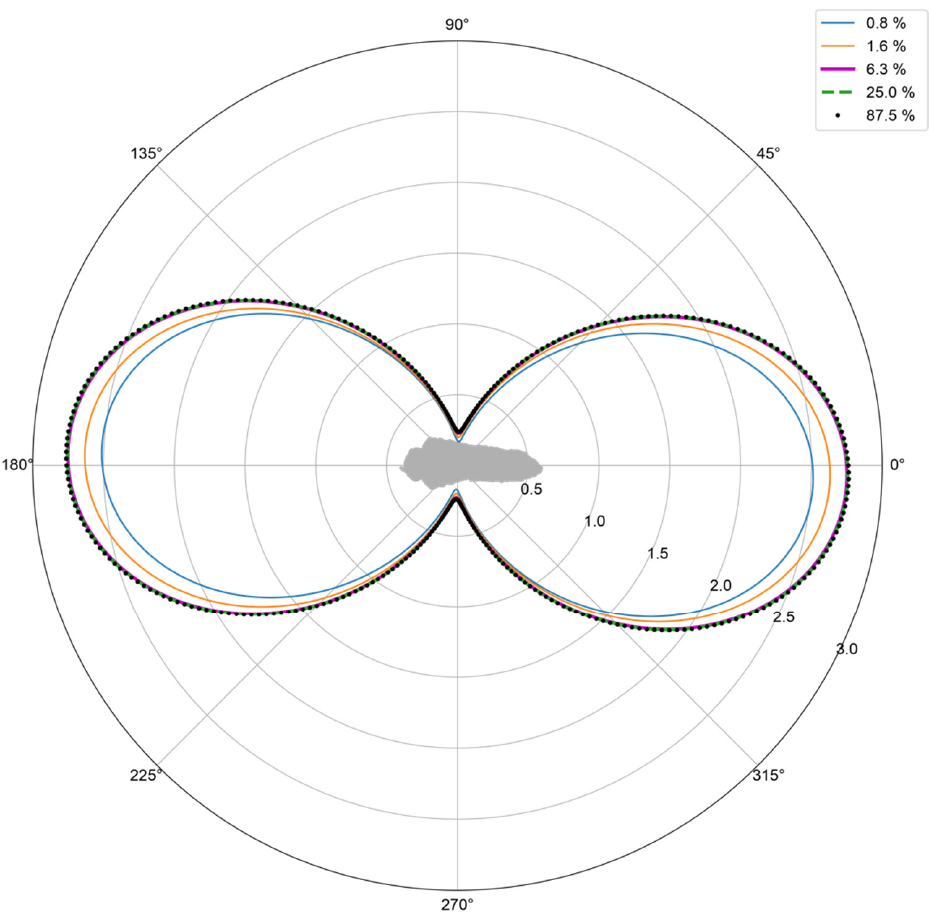
Figure 7. Comparison of the modelled polarimetric RCSs (cm 2 ) shown for the range of model decimations shown in Figure 3 with the addition of the highest fidelity model that we could achieve at 87.5%. These values are based on an incident radiation of 9.4 GHz at a ventral incident angle and use the simulation that excludes the impact of the wings and the legs and antennae, using the Body Only model and assumes a dielectric constant equal to that of MirkLBG (Table 1). The shadowed model is not to scale and for orientation purposes